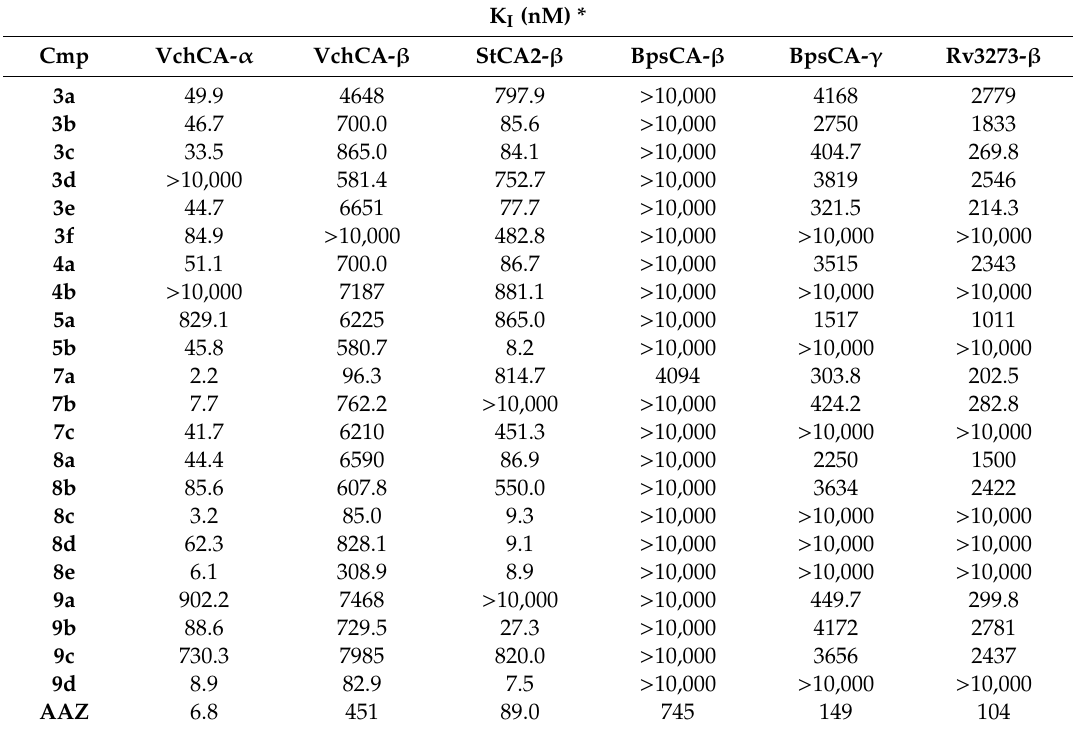
Table 1. Inhibition data against bacterial enzymes VchCA α - β , BpsCA β - γ , StCA2- β and Rv3273- β of compounds 3a-f , 4a-b , 5a-b , 7a-c , 8a-c , 9a-d and acetazolamide ( AAZ ) by a stopped flow CO 2 hydrase assay